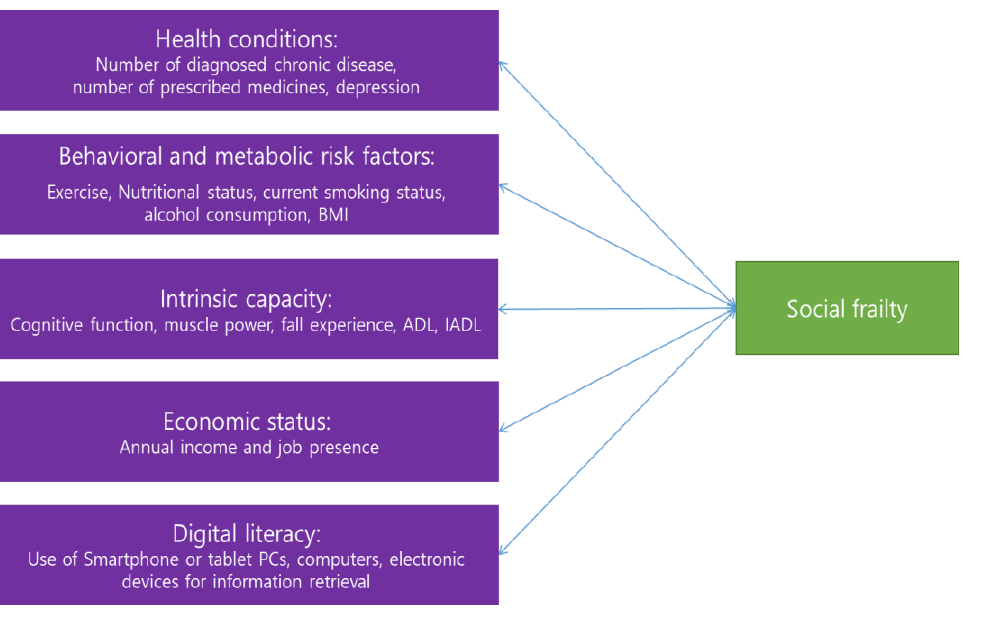
Figure 1. Conceptual framework for this study.